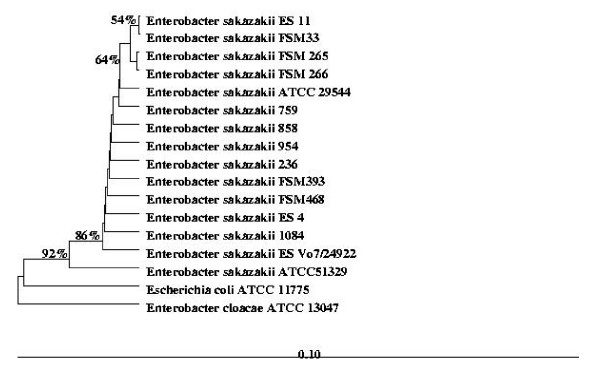
Phylogenetic tree comprising the the 16S rRNA gene sequence data of E. sakazakii strains obtained in this study in comparison to E. sakazakii type strain ATCC 29544, the E. cloacae type strain ATCC 13047 and the E. coli type strain ATCC 11775. The scale bar represents ten nucleotide substitutions per 100 nucleotides.